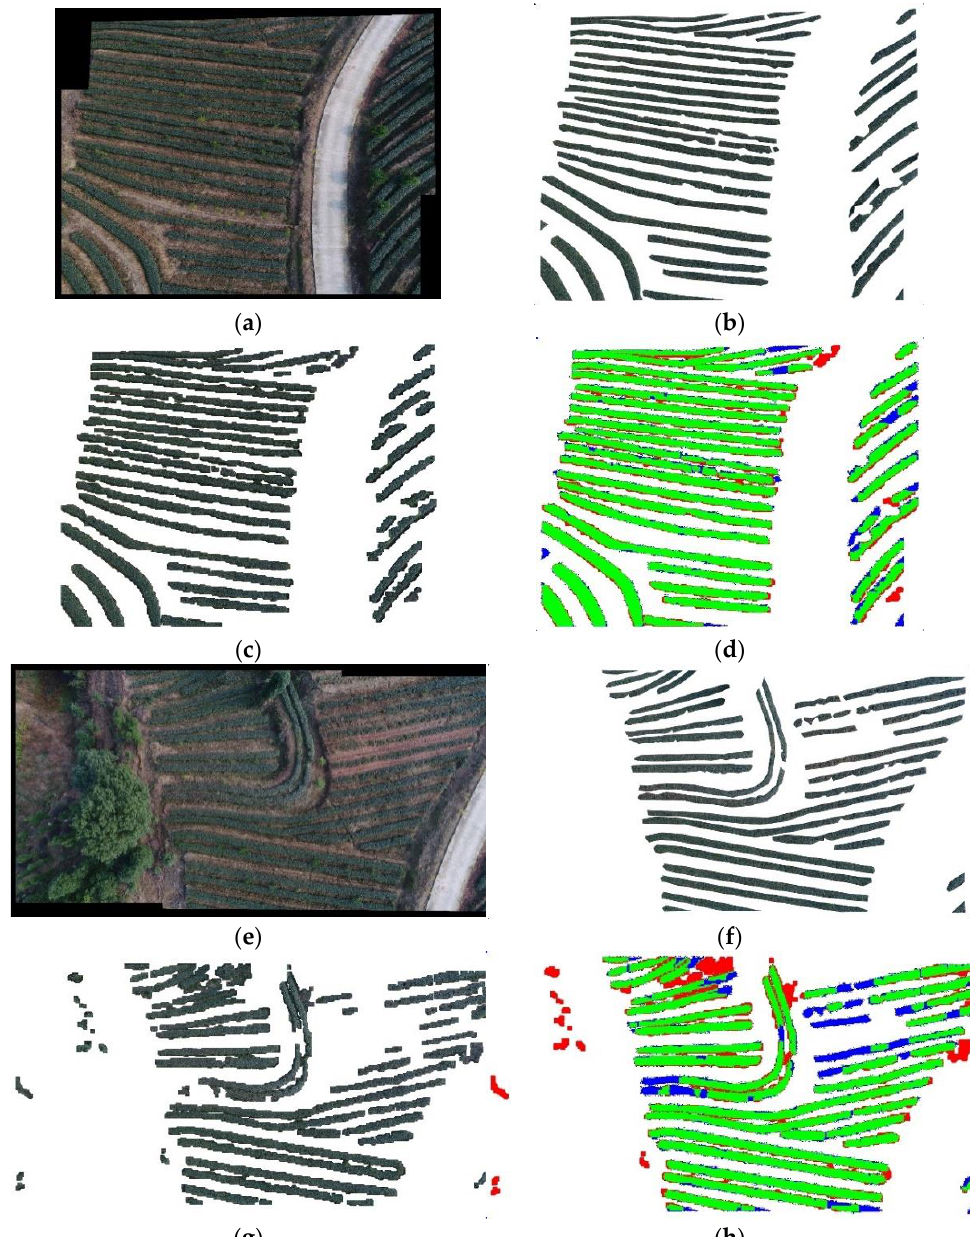
Figure 16. Contrastive example of the tea tree extraction from the tea garden mosaic images. ( a ) mosaic image 1; ( b ) tea tree extracted as the ground truth of ( a ); ( c ) tea tree extracted in this study; ( d ) result of the contrast between ( b ) and ( c ); ( e ) mosaic image 2; ( f ) tea tree extracted as the ground truth of ( e ); ( g ) tea tree extracted in this study of ( e ); and ( h ) the result of the contrast between ( f , g ).